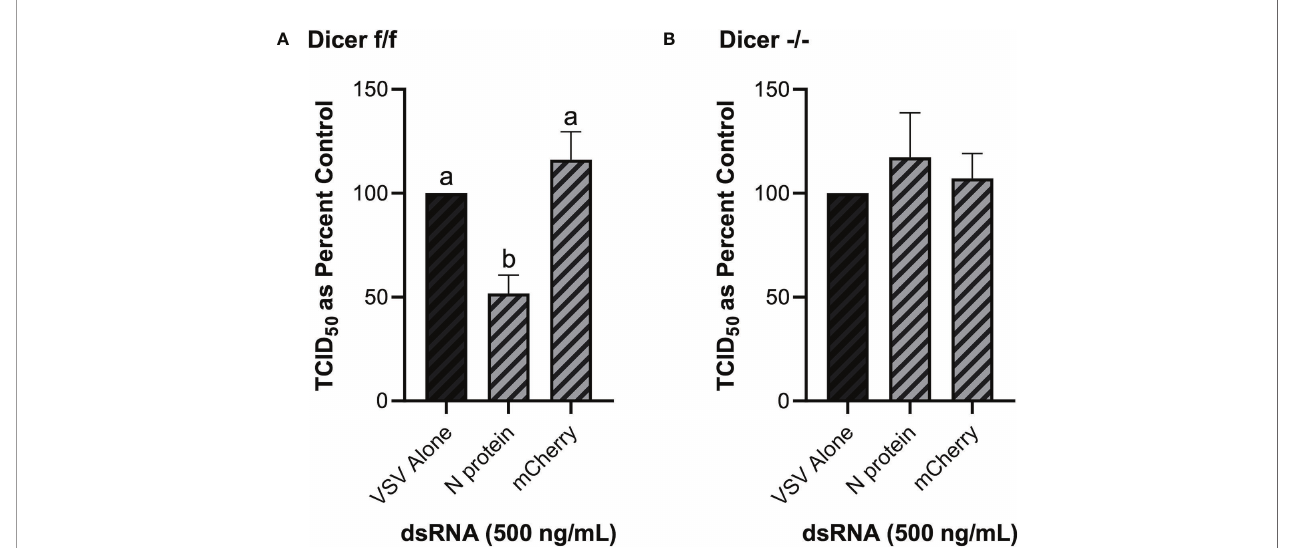
FIGURE 8 | The observed viralinhibition bylong dsRNA soakingisdependent onthe presence offunctional Dicer proteins. Mouse MSCs that had functionalDicer1were pre-soaked for 2h with DPBS or 500 ng/mL of either mis-matchedmCherry dsRNA or matched VSV N protein dsRNA before infection with VSV-GFP (MOI = 0.1) for 24h (A) . The matchingmouse MSC cellline that was a KOfor Dicer1were also pre-soaked for 2h with DPBS or 500 ng/mL ofeither mis-matchedmCherry dsRNA or matched VSV N protein dsRNA before infection with VSV-GFP (MOI= 0.1) for 24h (B) . Error barsrepresent +SEM, andeach data point represents the average of 6 independent replicates. A p-value of less than 0.05 was considered to bestatistically signi fi cant. Error barswith different lettersrepresent signi fi cantlydifferent